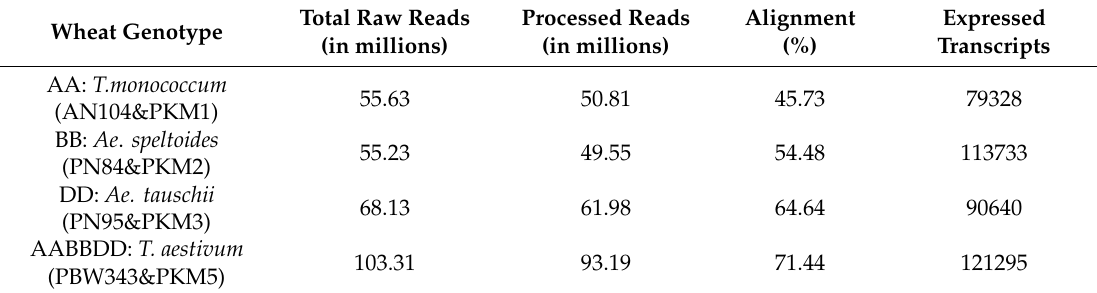
Table 2. Summary of RNA-Seq libraries generated from bread wheat (AABBDD) and their progenitors (AA, BB, DD).